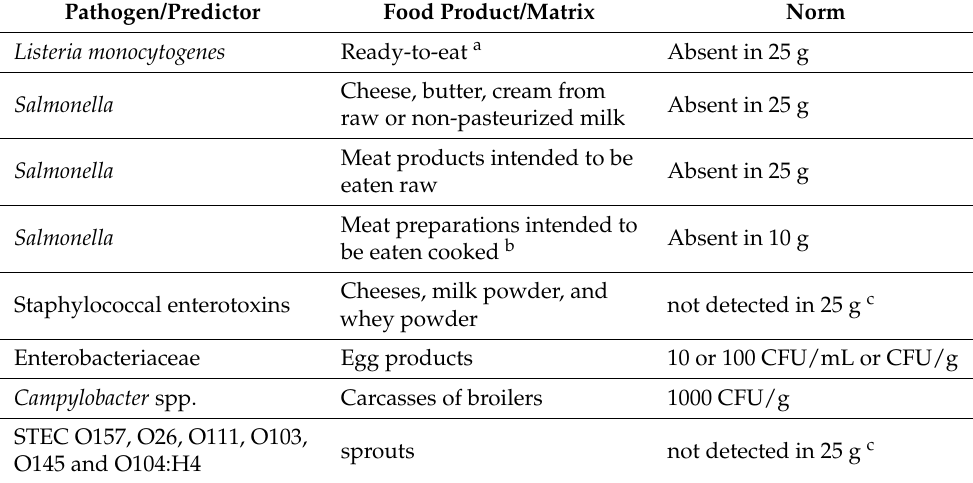
Table 3. A selection of norms for pathogenic MOs in some food products [3]. The criteria apply at different stages in the food-chain and are associated with a sampling plan and with certified ISO methods not indicated or included in this